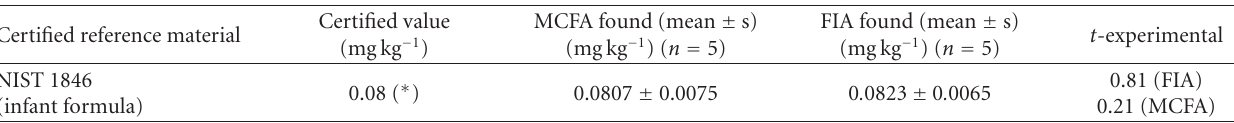
Table 5: Total selenium contents found in standard reference material for both flow systems. Total selenium contents found in